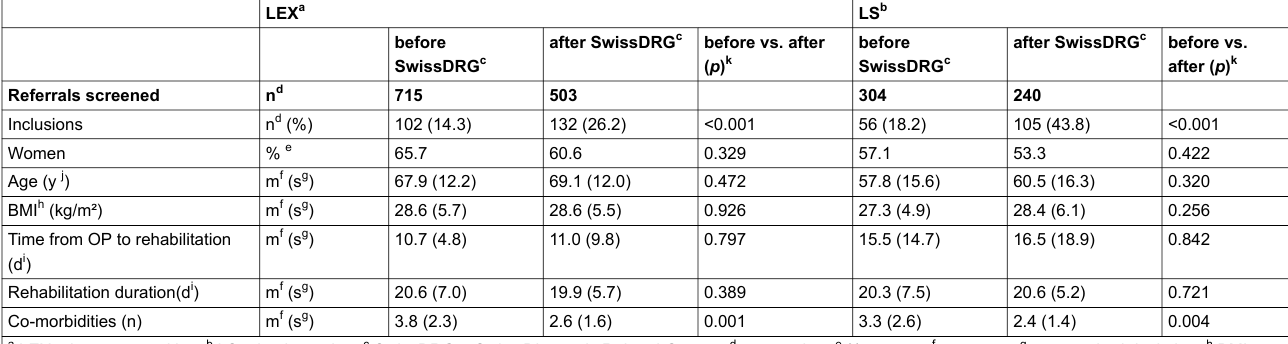
LEX a LS b before after SwissDRG c before vs. after before after SwissDRG c before vs. SwissDRG c ( p ) k SwissDRG c